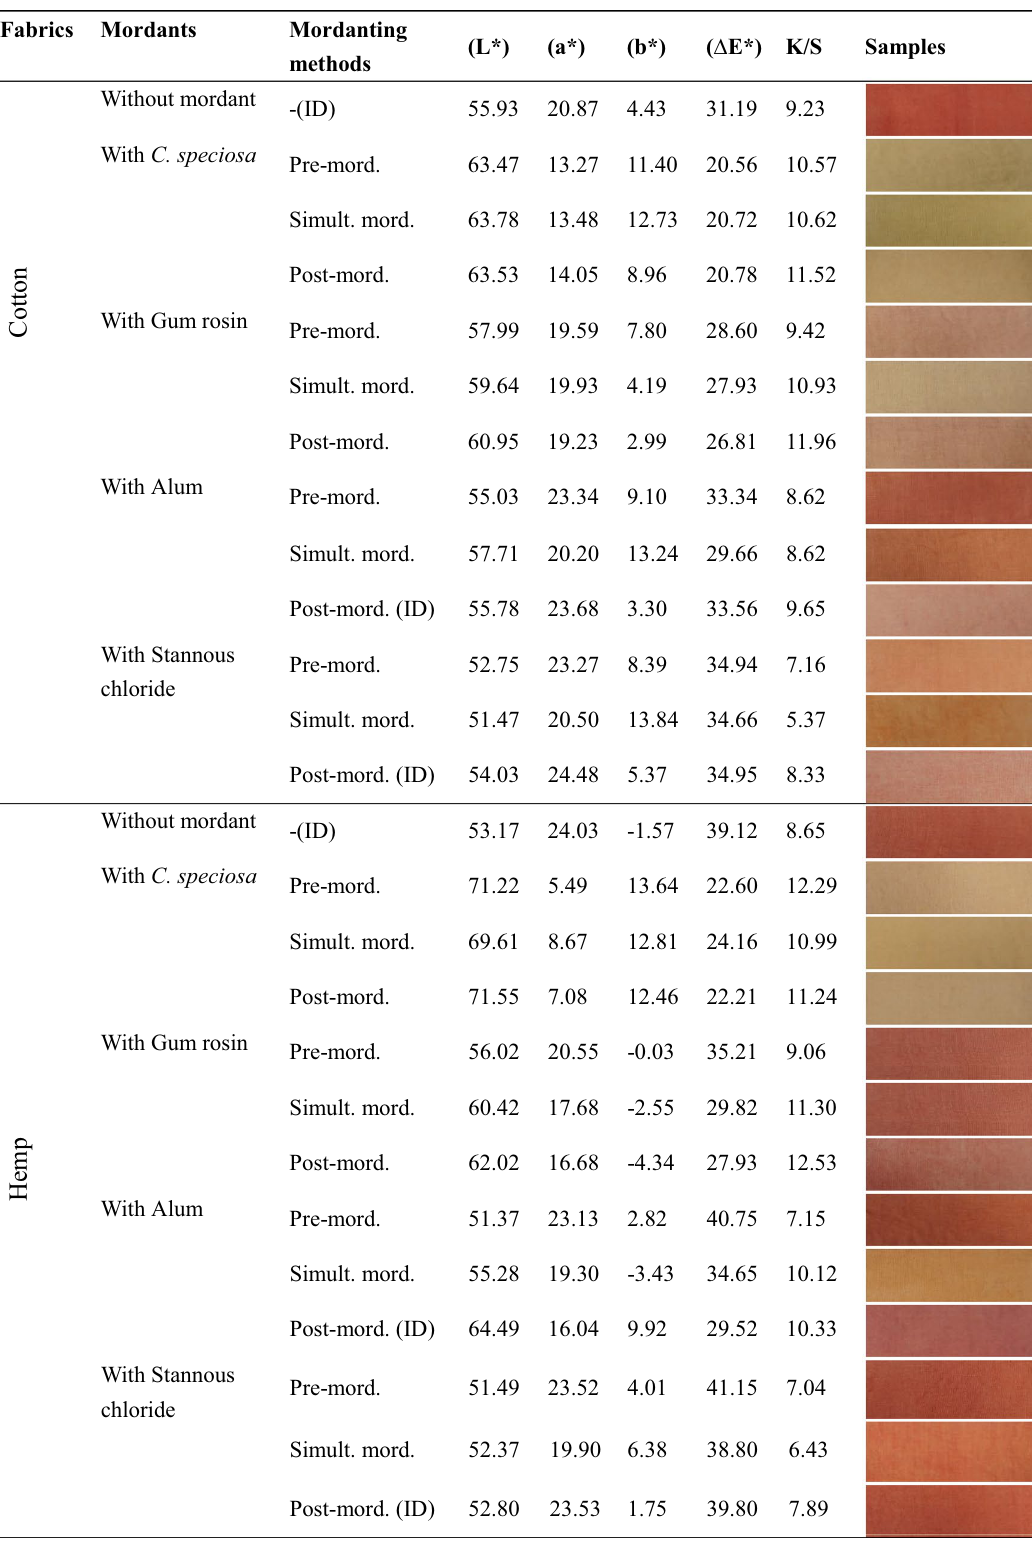
Table 3. K/S values and colorimetric data of madder dyed fabrics with and without mordanting. ID, Indigenous madder dyeing; Pre-mord, Pre-mordanting; Simult. mord., Simultaneous mordanting; Post-mord, Post